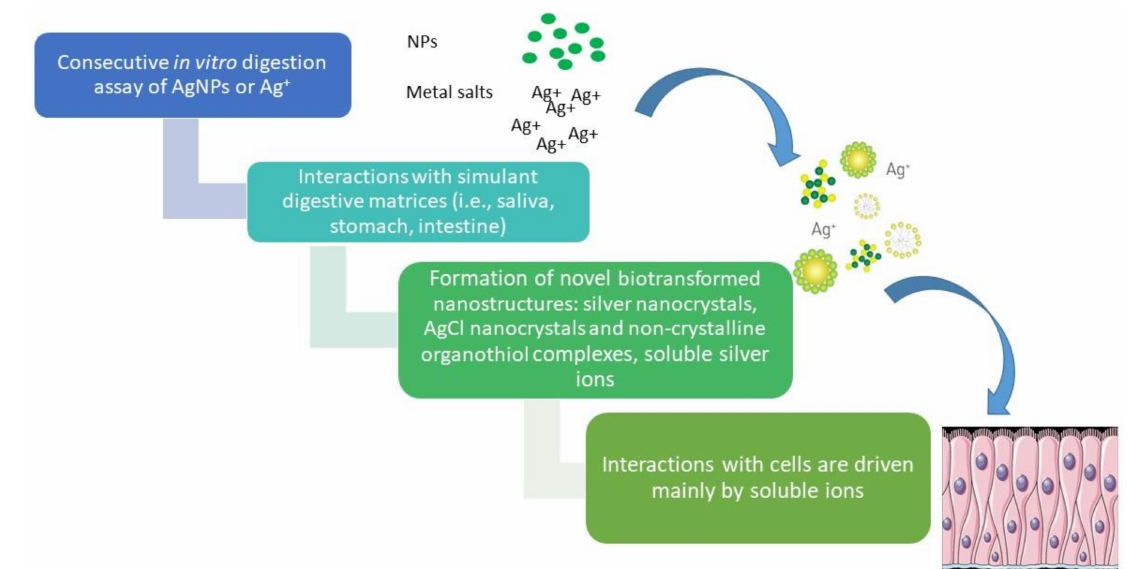
Scheme 3. Schematic representation of the biotransformation by consecutive in vitro digestion assay and generation of soluble silver ionic complexes which trigger a cellular response of the intestinal